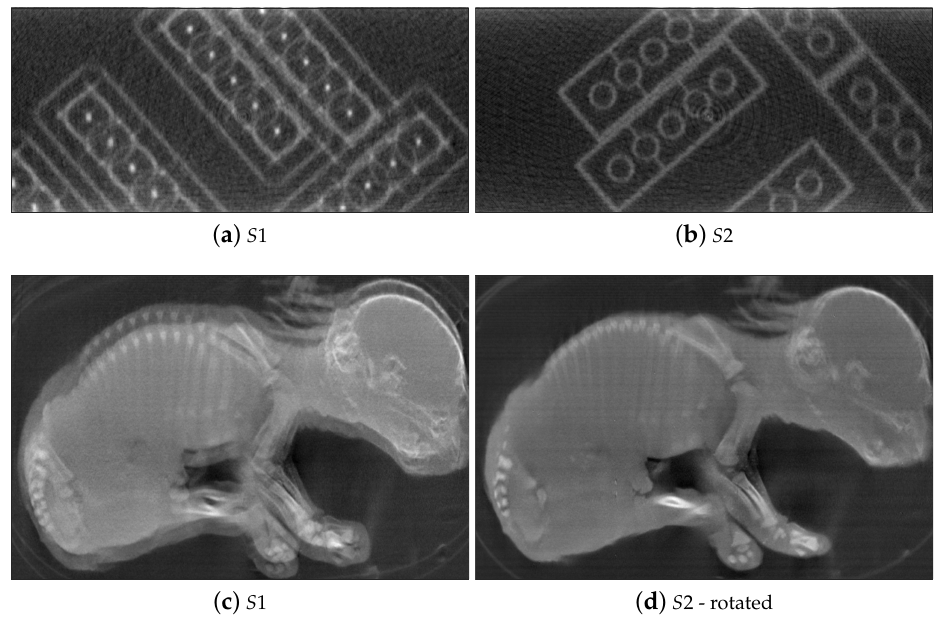
Figure 5. Reconstructions of the test phantom and the piglet with real datasets acquired by the 3D 2 YMOX system and the initializations of the stereo geometry parameters. The misalignment artifacts is less severe in the reconstruction with S 2, D 2 datasets ( b , d ) compared to ( a , c ) due to the initializations of the geometric parameters turning out to be more precise.